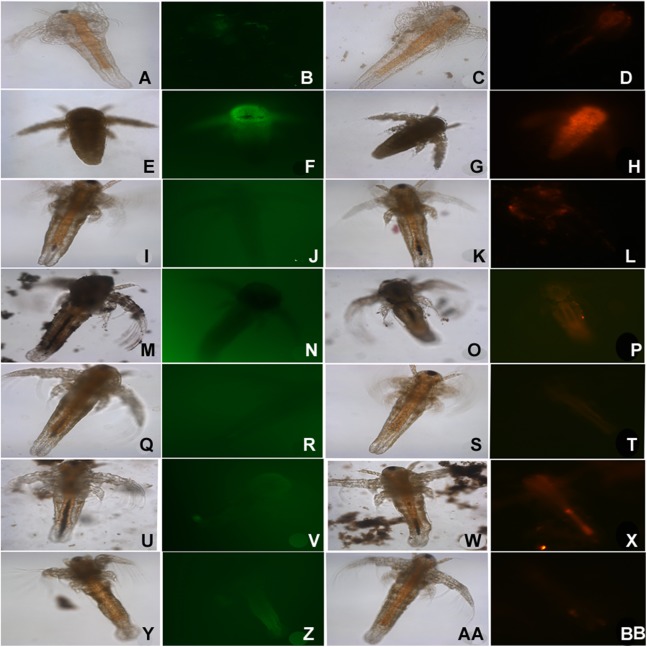
ROS staining of dead nauplii.Nauplii of Artemia in standard ARC test stained with DCFDA (green) for ROS and DHE (Red) for superoxide accumulation due to stress. Nauplii exposed to silver NPs, TiO2 and SiO2 NP show higher staining for both ROS and superoxide at 24 h. (A–D) Control; (E–H) silver NP; (I–L) gold NP; (M–P) CuO NP; (Q–T) ZnO—NP; (U–X) titania and (Y–BB) SiO2NP.